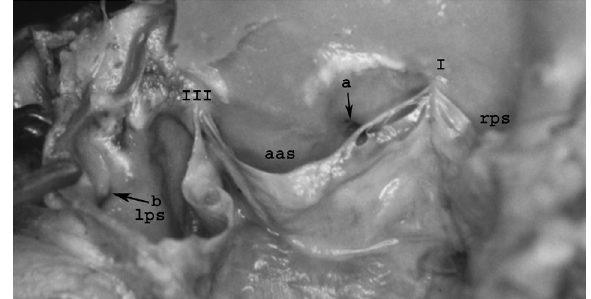
Figure 5 - The right coronary ostium below the level of upper margin of the cusp (arrow a) in the anterior aortic sinus (aas). A slit-like ostium (arrow-b) of the left coronary artery is also seen in the left posterior sinus (lps)